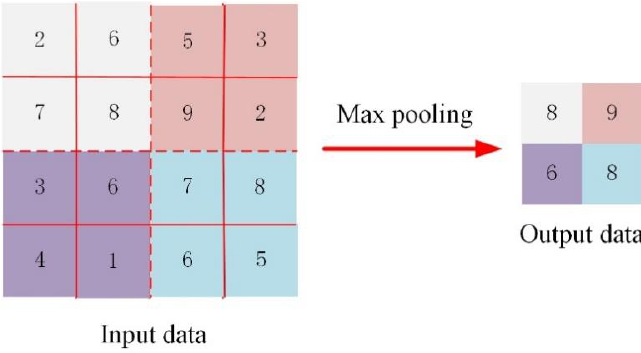
Figure 5. Schematic diagram of the convolution process.